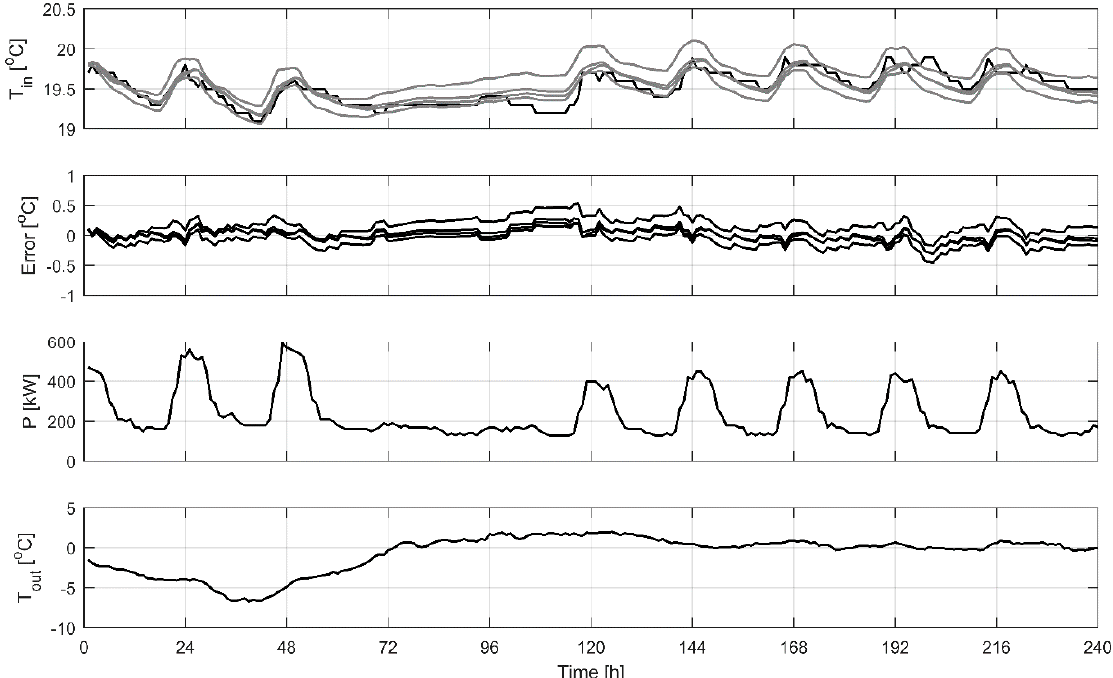
Figure 5. Ten-day indoor temperature simulation for building A with model structure P1P3 utilizing the same four sets of parameters that were estimated in the 4-fold cross-validation. The measured (black line) and the estimated (grey lines) indoor temperatures are presented in the top. Error plots show the evolution of the modelling error during the ten-day simulation period.